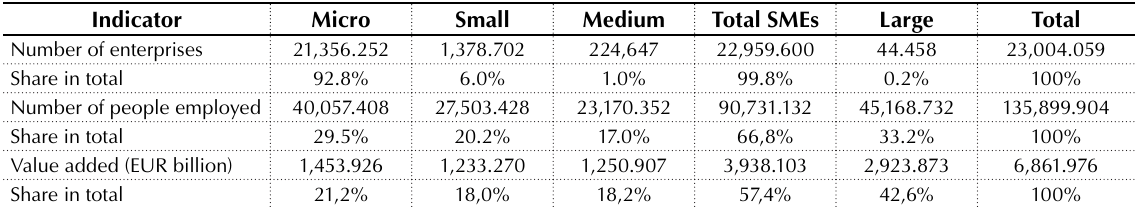
Table 1. The number of enterprises, employment and value added by SMEs and large enterprises in the EU-28 in